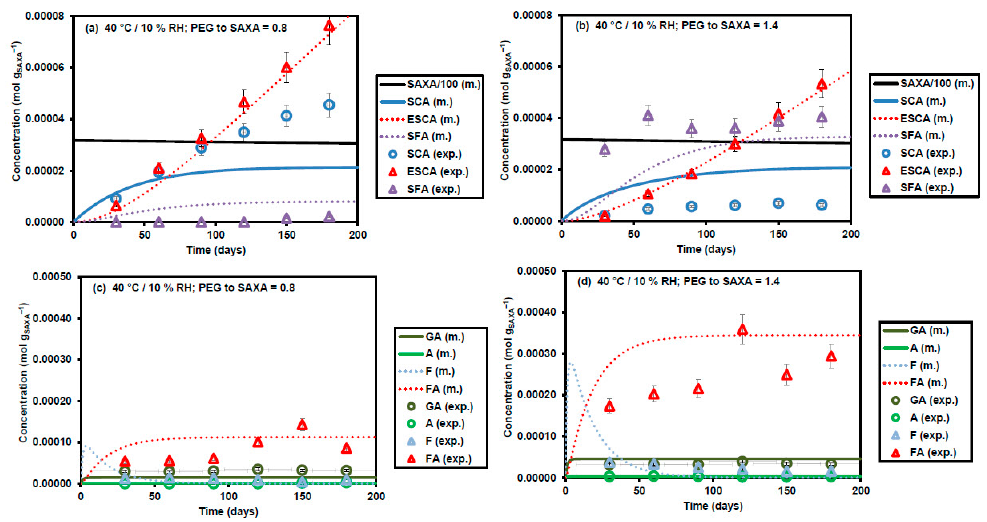
Figure 9. The updated model results for concentration of saxagliptin (SAXA) degradation products (amidine (SCA), epimer (ESCA), and formyl amide (SFA)) or polyethylene glycol polymer (PEG) degradation (glycolic acid (GA), acetaldehyde (A), formaldehyde (F), and formic acid (FA)). Lines represent fitted model (m.), markers experimental data points (exp.). Tablet degradation tests were executed at the temperature of 40 °C, the nominal water activity of 10% and the initial PEG to SAXA weight ratios of 0.8 ( a , c ) and 1.4 ( b , d ). A relative error of 10% is set based on sum of estimated analytical and sample variability.